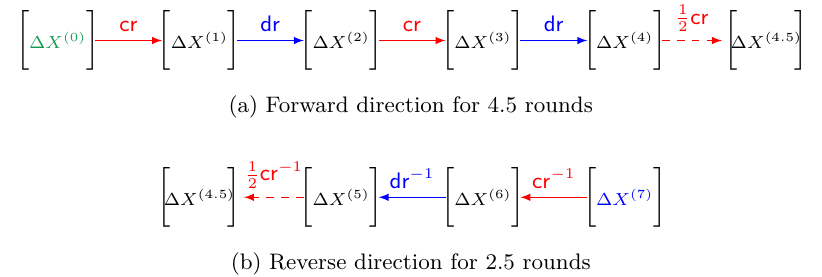
Figure 1: The two steps procedure for attacking 7 rounds of ChaCha using a 4.5 round bias. The columnround (shortened to cr ) and diagonalround (shortened to dr ) are represented by red and blue arrows respectively.The half round of ChaCha discussed earlier is represented by a dashed arrow. We follow the same notations for the reverse